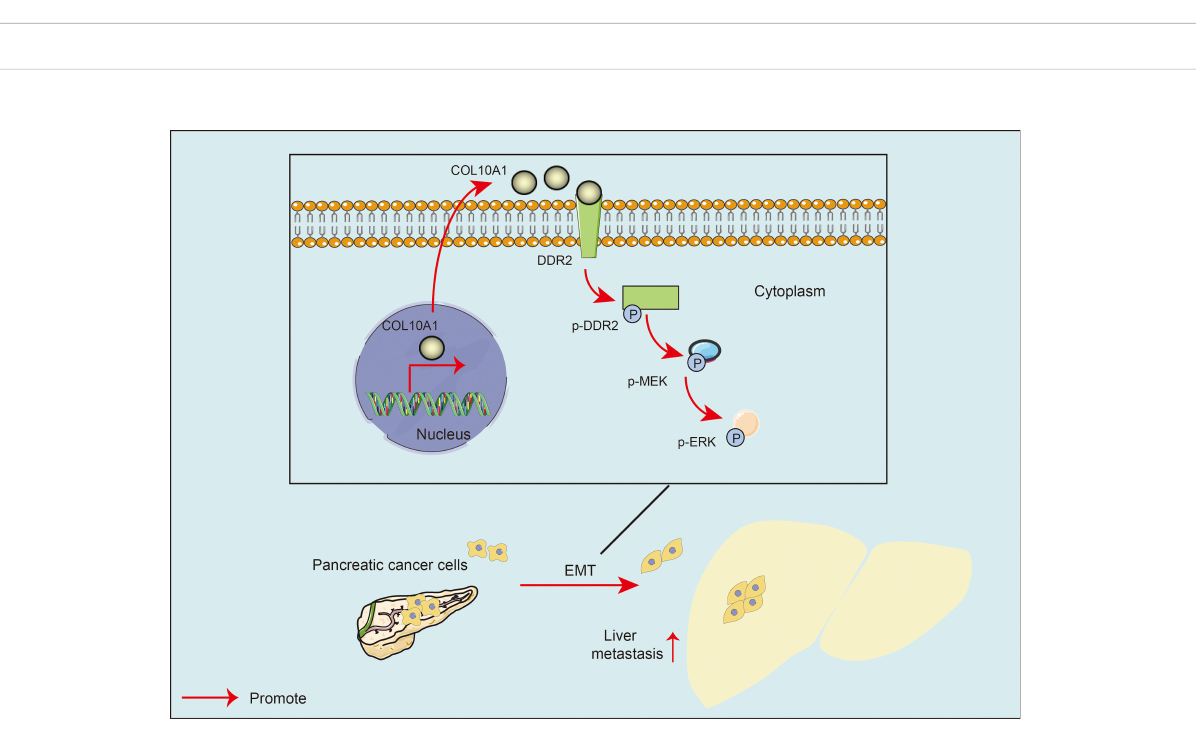
FIGURE 7 Model: COL10A1 activated the MEK/ERK signaling pathway of pancreatic cancer cells and promoted the EMT of pancreatic cancer cells through a DDR2-dependent